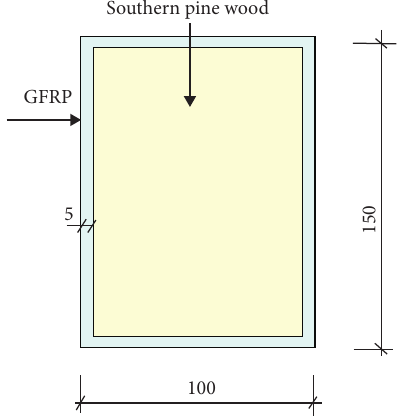
Figure 5: Cross section of the composite sandwich elements (units: mm). Table 3: Dimensions of the angle steel.